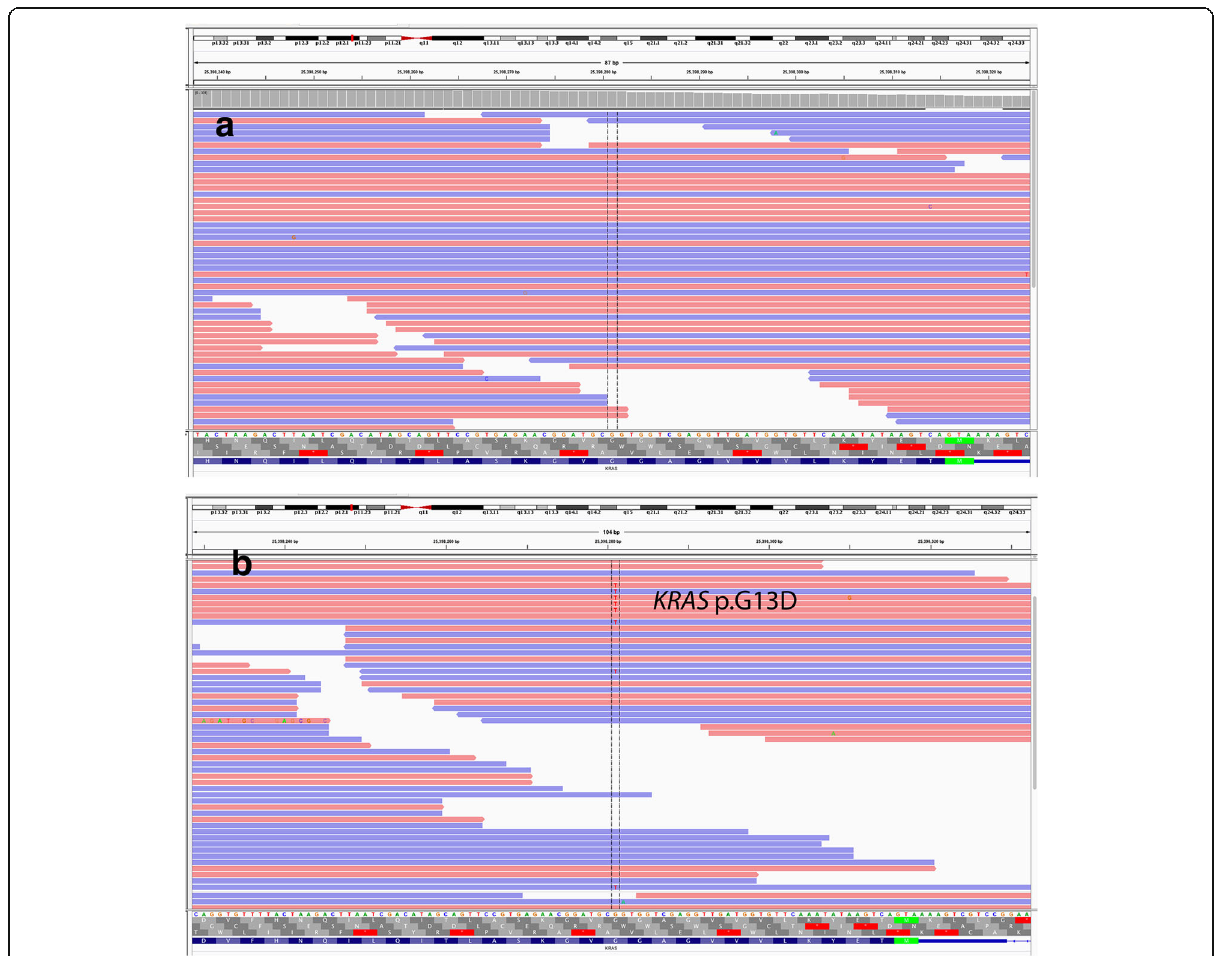
Fig. 6 Exome sequencing performed on the Langerhans cell sarcoma sample revealed a G13D mutation results in an amino acid substitution at position 13 in KRAS , from a glycine to an aspartic acid (Variant allele frequency: 0.24) ( b ). This KRAS p.G13D mutation was not present in the previous follicular lymphoma ( a